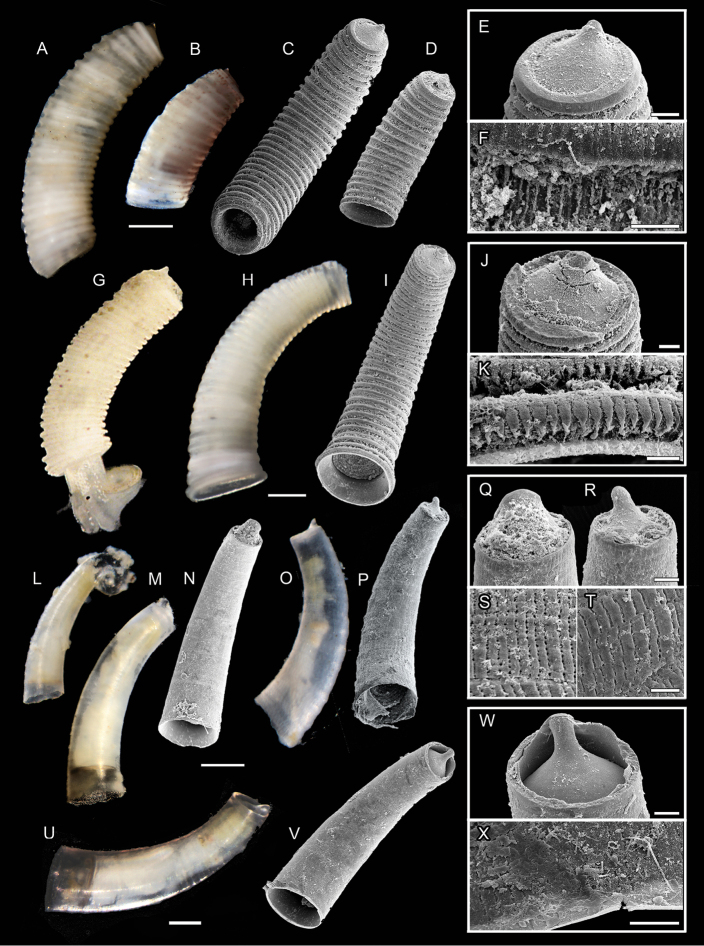
A–FCaecum
pulchellumA, C, E, F specimen ZSM-Mol-20090485 B, D juvenile specimen ZSM-Mol-20200118 A, B light microscopic pictures C, DSEM scans E close-up of mucro and F microsculpture H–KC.
donmoorei, specimen USNM 1618844 H–KC.
regulare, specimen ZSM-Mol-20100321, juvenile H light microscopic picture ISEM scans J close-up of mucro and K microsculpture L–TC.
cf.
teres and C.
cf.
strangulatumL specimen ZSM-Mol-20200033, juvenile specimen with larval shell still attached M, N, Q, S specimen ZSM-Mol-20200032, juvenile M light microscopic picture NSEM scan Q close-up of mucro and S microsculpture O, P, R, TC.
cf.
strangulatum, specimen ZSM-Mol-20200038, juvenile O light microscopic picture PSEM scan R close-up of mucro and T microsculpture U–XC.
cf.
semilaeve, specimen ZSM-Mol-20200034 U Light microscopic picture VSEM scan W close-up of mucro and X microsculpture. Scale bars: 10 µm (F, S, T, W, X); 20 µm (J, K, Q, R); 50 µm (E); 100 µm (H, I, L–P, U, V); 200 µm (A–D).